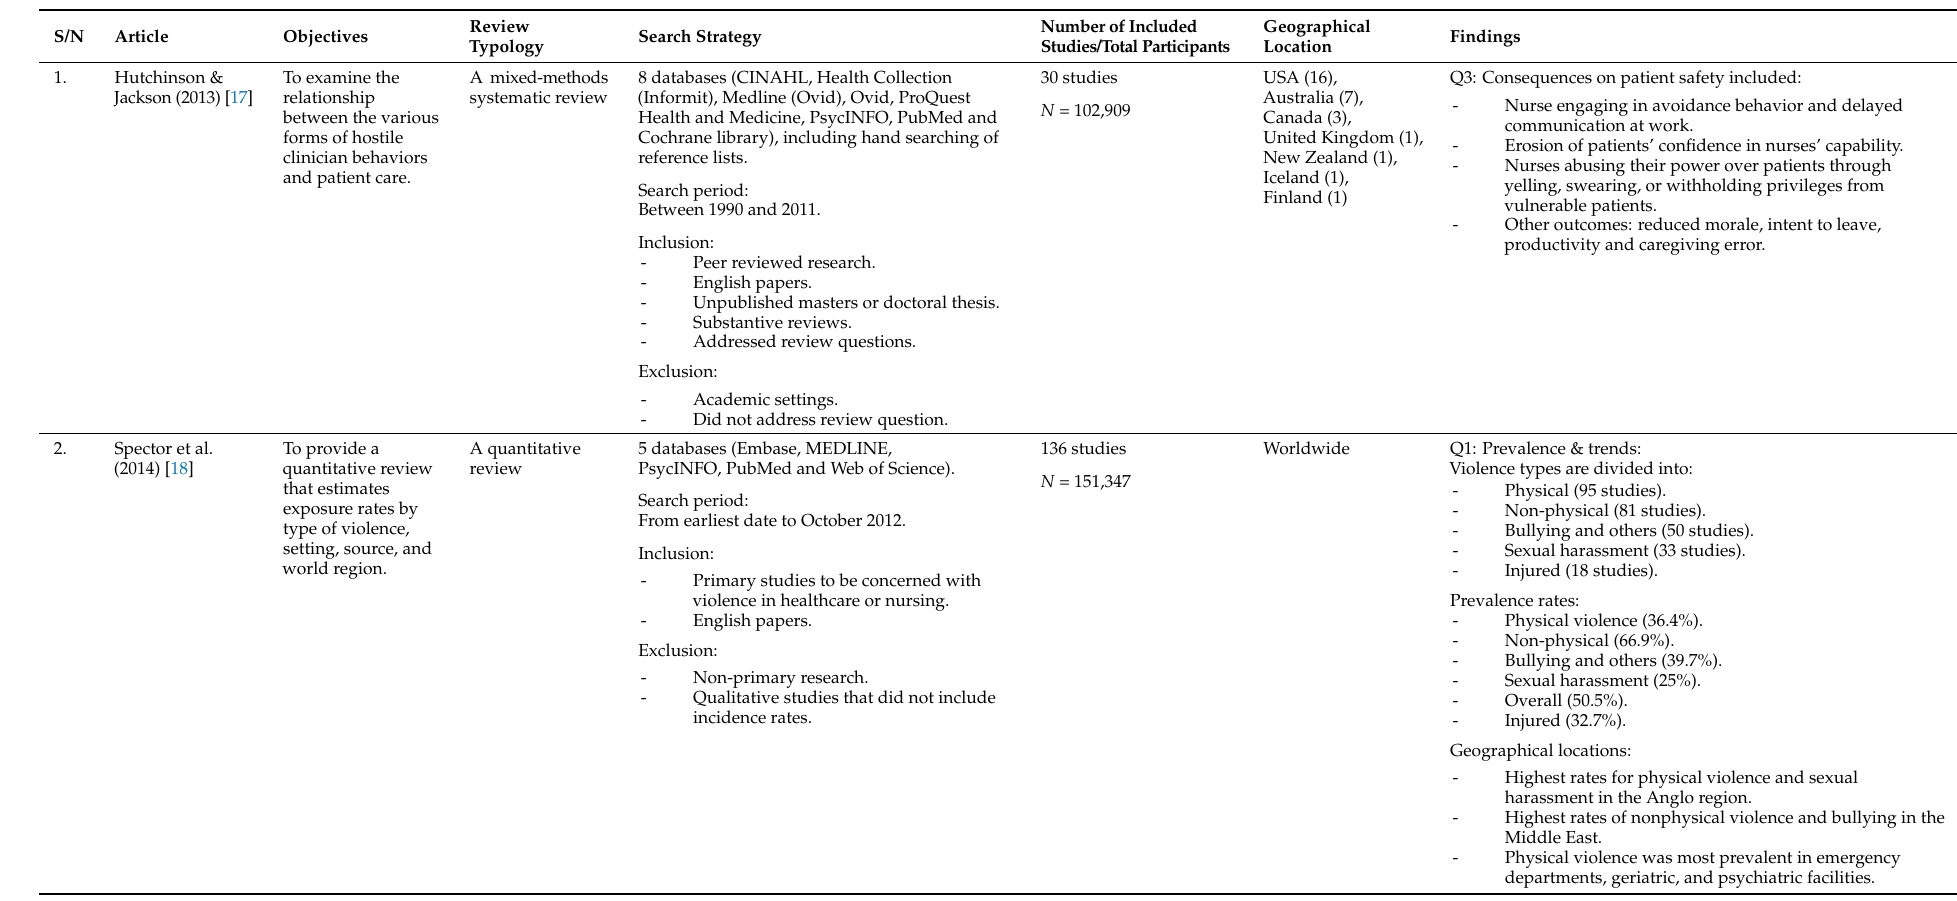
Table 1. Summary table for included systematic